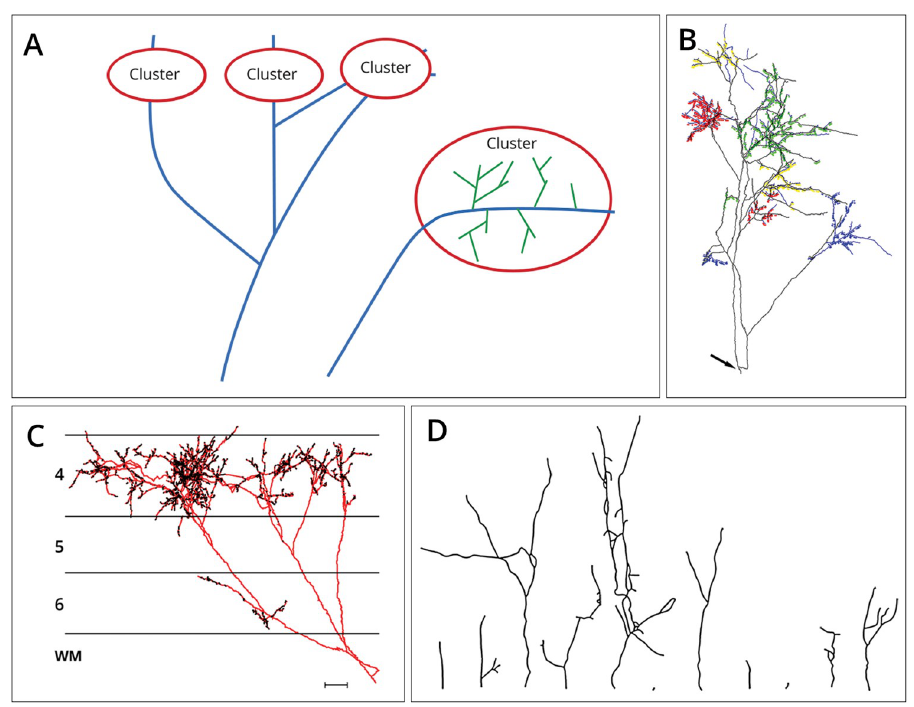
Fig 1. Thalamocortical arborizations in cat primary visual cortex. (A) Clusters containing florets (green) and long- range axonal projections (blue). Besides a higher branching probability than present at the axonal trunk, florets can be characterized by a higher bouton density. The long-range axonal parts outside of the clusters in contrast display fewer branching occurrences, longer branches, and a lower bouton density [4, 10]. (B) Labeled Y axon terminals of cat primary visual cortex arborising in layers 4 and 6. The axon was reconstructed from serial sections and has been rotated to optimize the view of the coloured florets. The axon emerges from the white matter at the location indicated by the arrow. (C) Displayed is the same axon (red) as in (B), here however from a coronal view. The axon emerges from white matter, here indicated by ‘WM’. The terminals of the axon focussing on layers 4 and 6 are indicated in black. A horizontal 100 micron scale bar appears in the bottom right hand corner. (D) Florets aligned by their root segments. Floret morphology is highly variable, with florets consisting of only a single segment (‘trivial florets’) as well as larger florets with many and highly diverse segments being present in the dataset. All experimental data is courtesy of Kevan A.C. Martin and colleagues, Institute of Neuroinformatics,